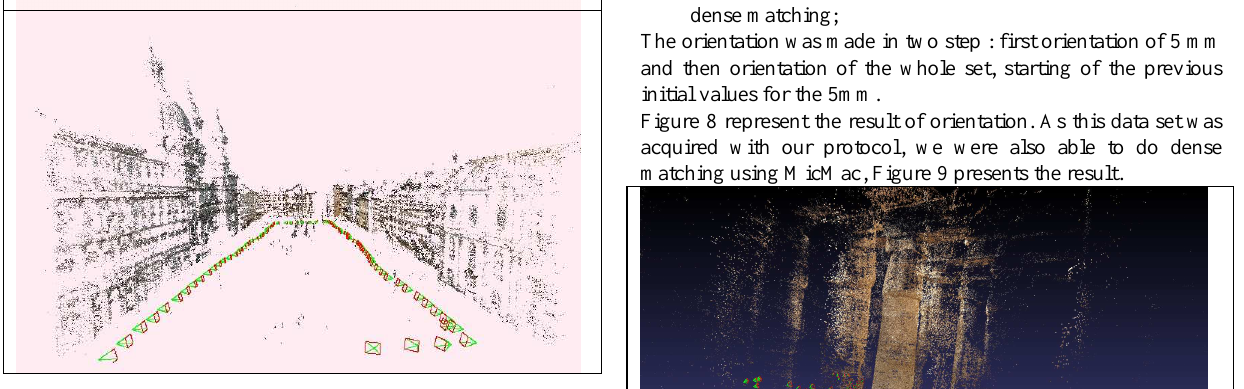
Figure 7. Result on piazza navona.